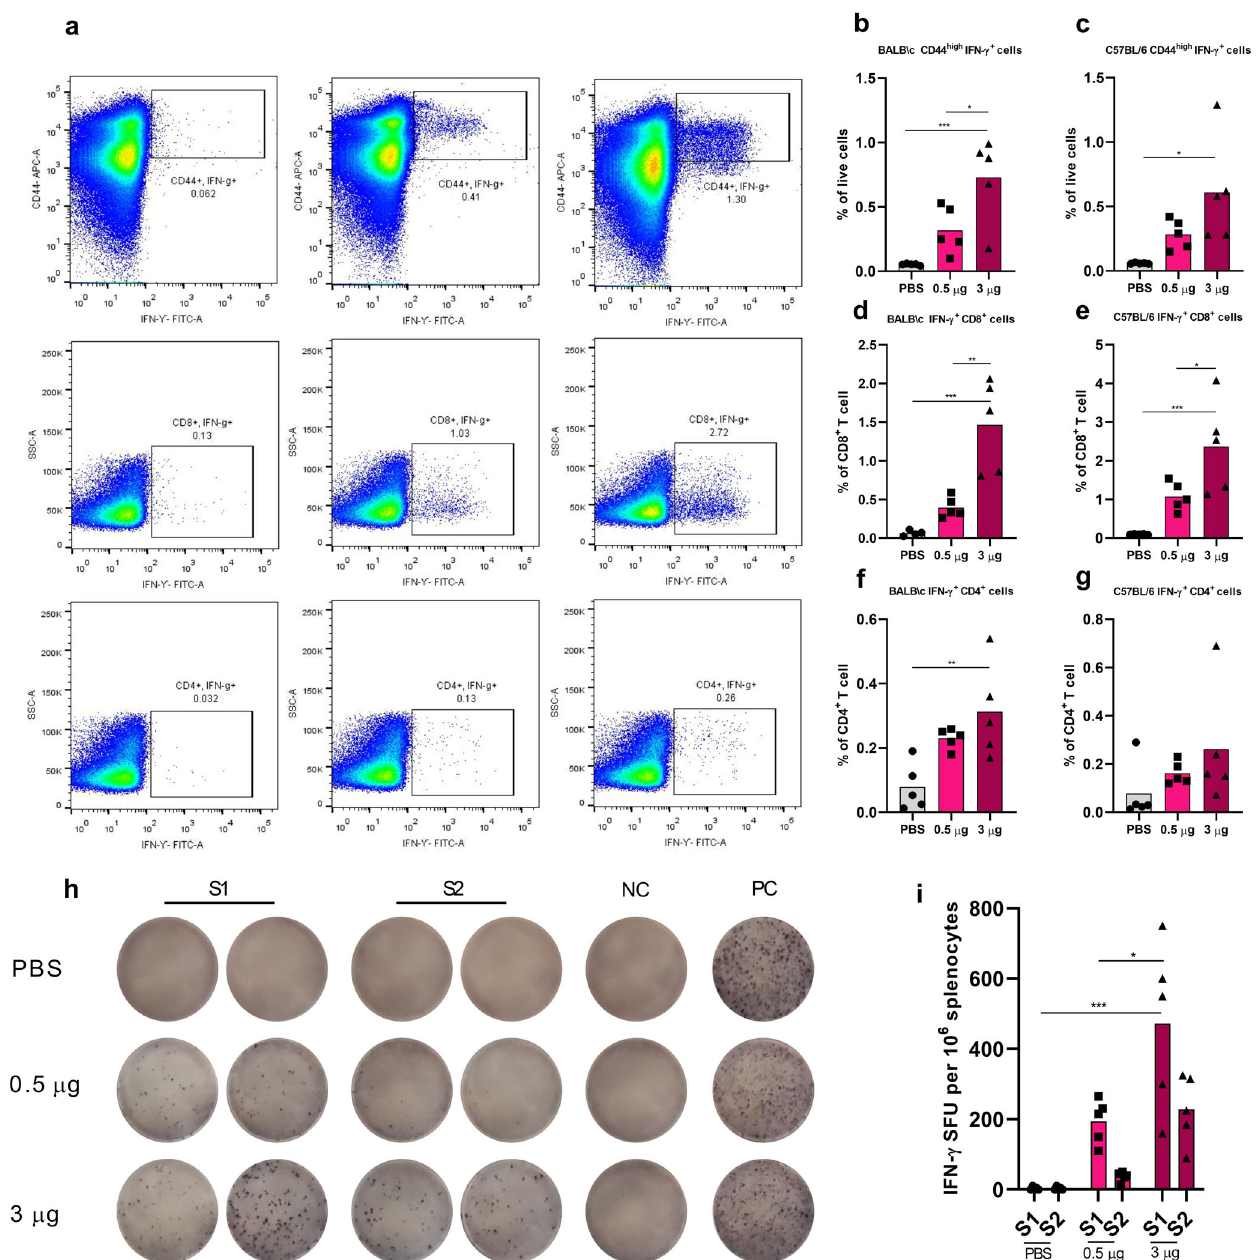
Fig. 3 Induction of potent cellular immunity by COReNAPCIN ® . Mice were i.m. injected at days 0 and 21 with 0.05 (light pink), 0.5 (pink) or 3 µg (purple) of COReNAPCIN ® . Animals in the control group received PBS injection (gray). Splenocytes from fi ve mice each group, were collected at day 21 post boost and subjected for the following assays. a – g Following stimulation with SARS-CoV-2 Spike peptide pool for 8 h, the frequency of Spike speci fi c CD44 high IFN- γ + cells ( b , c ), CD8 + IFN- γ + cells ( d , e ) and CD4 + IFN- γ + cells ( f , g ) in both mouse strains, were quanti fi ed using fl ow cytometry. Representative dot plots in ( a ) showing fl ow cytometry gating summary used for measuring IFN- γ -producing Spike speci fi c T cell populations in C57BL/6 splenocytes. h , i BALB/c splenocytes were restimulated with two SARS-CoV-2 Spike peptide pool (S1 and S2) for 18 h and IFN- γ -secreting T cells were quanti fi ed with an ELISpot assay. In ( h ), the representative images of ELISpot wells, columns from left to right are: responses of splenocytes to S1 SARS-CoV-2 peptide pool (as duplicate), S2 SARS-CoV-2 peptide pool (as duplicate), DMSO (a negative control), and PHA (an unspeci fi c positive control). Each row represents an individual mouse.). In bar plots, each data point is shown and the height of each bar represents the mean. All statistical analyses were performed using one-way ANOVA followed by multiple comparisons Dunn ’ s post-hoc test. A p value less than 0.05 (*P < 0.05, ** P < 0.01, *** P < 0.001) was assumed to be statistically signi fi reciprocal endpoint titer of 1.5 × 10 6 and 1.5 × 10 7 , respectively antibody waned overtime, its reciprocal endpoint titer was remained more than 10 5 up to day 91 post prime (Fig. 5b).